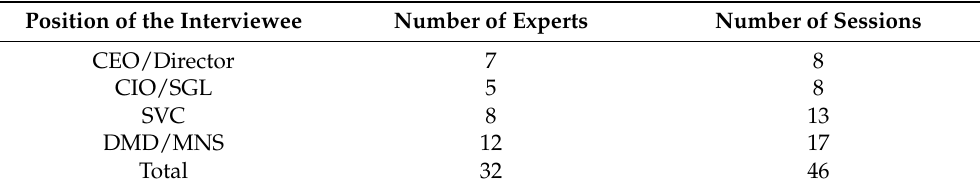
Table 2. Summary of the interviews.